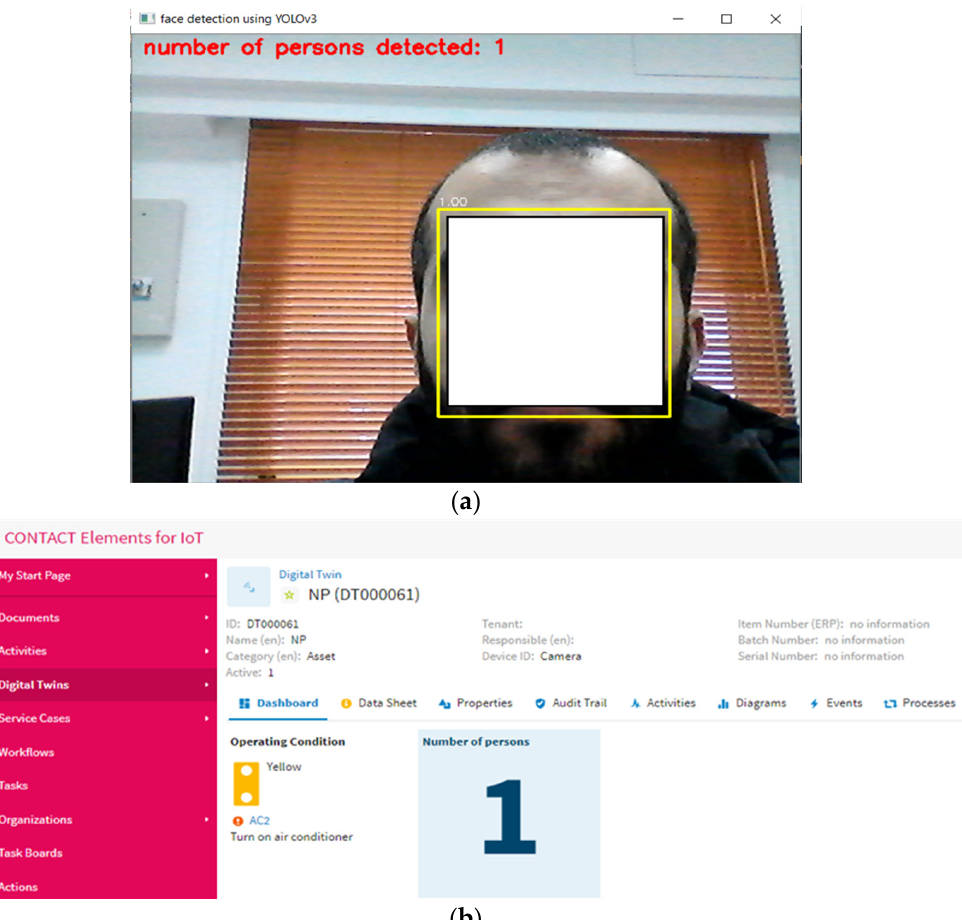
Figure 10. The number of persons detected in the case of scenario 1: ( a ) the output of YOLOv3 algorithm, ( b ) the presented output on the dashboard of the IoT platform.